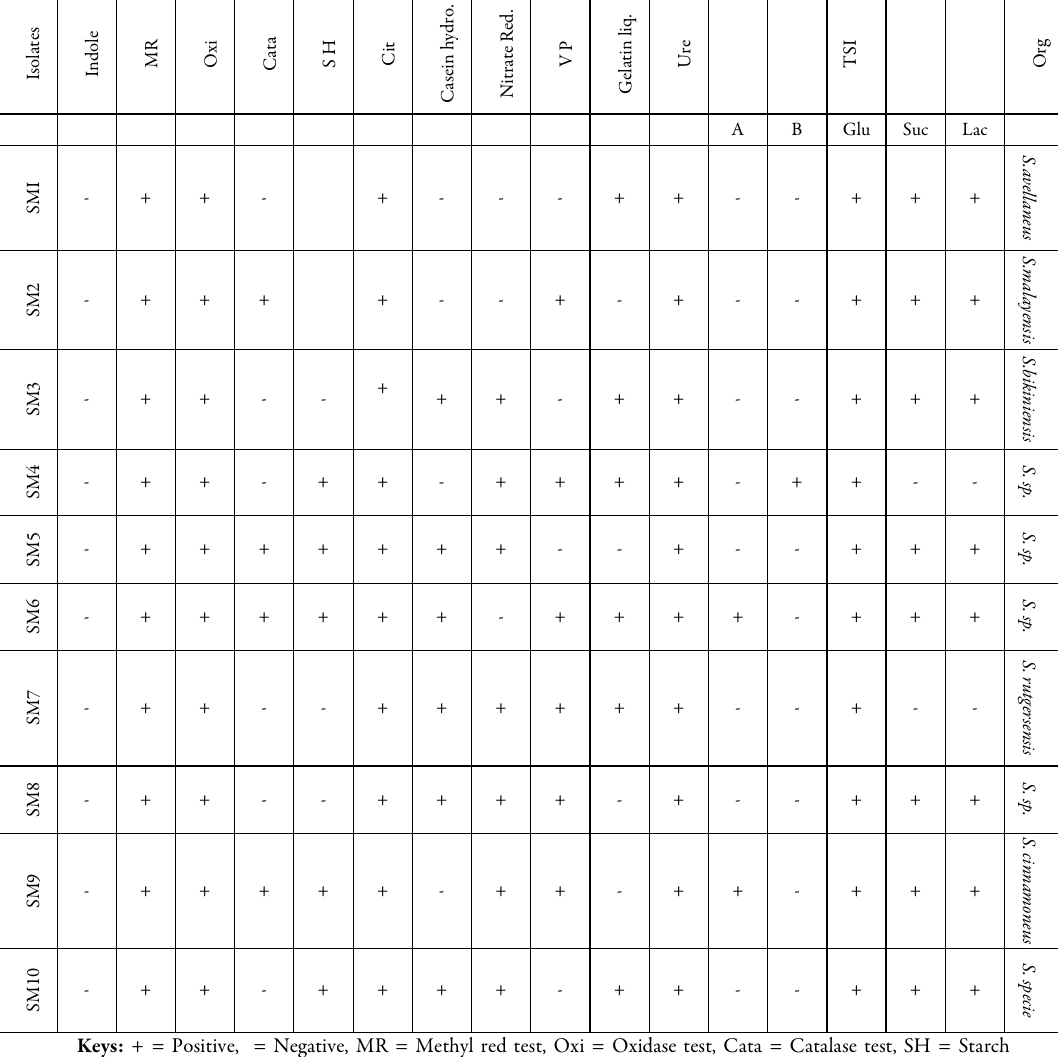
Table 4. Biochemical characterization of